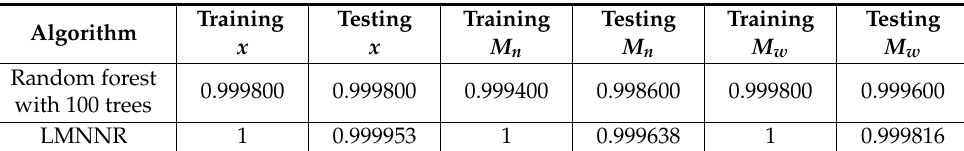
Table 1. Performance of the best Weka algorithm for the monomer conversion ( x ), numerical average molecular weight ( M n ) and gravimetrical average molecular weight ( M w ) vs. Large Margin Nearest Neighbor for Regression